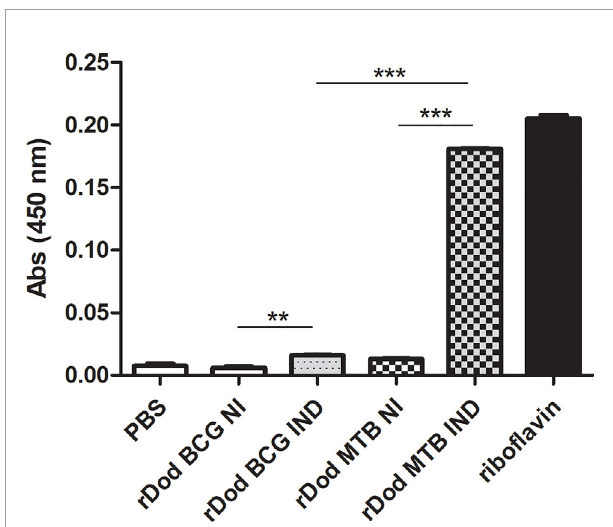
FIGURE 5 | Ribo fl avin-binding capacity of BCG and M.tb dodecin forms. Ribo fl avin ( l =450nm) detected on 10kDa fi lter retentate after incubation of saturated ribo fl avin solution with whole protein extracts from non-induced (NI) or induced (IND) E. coli cultures expressing M.tb or BCG Moreau (BCG) dodecin genes (rDod). The saturated ribo fl avin solution was used as maximum value and PBS as a negative control (C-), respectively corresponding to a situation in which all or none of the ribo fl avin in the input solution bound to dodecin within lysates. Results are represented as the mean +/- SD of a set of three independent experiments. Statistical analysis was performed by unpaired t-test. **p < 0,01, ***p <